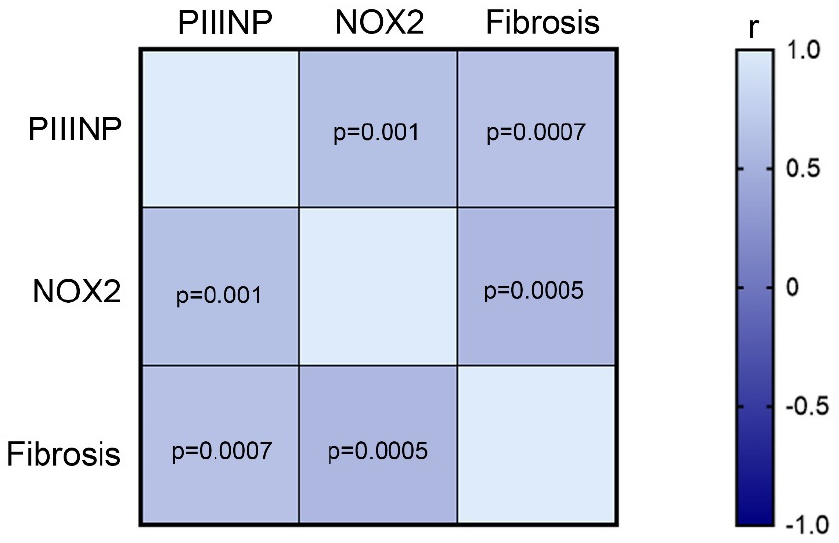
Figure 5. PIIINP and NOX2 levels correlate with fibrosis. Heatmap showing the correlation among the levels of PIIINP, NOX2, and fibrosis at T1 in patients included in our study.